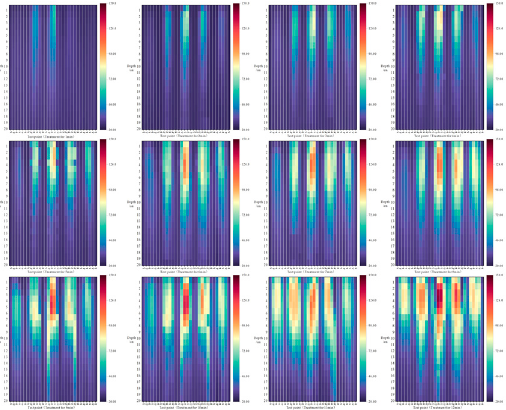
Figure 16. Heatmap of the internal temperature of 10% loess under microwave irradiation.